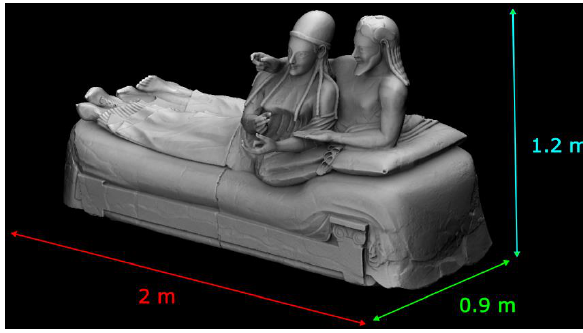
Figure 2. Sarcophagus encumbrance without the supporting